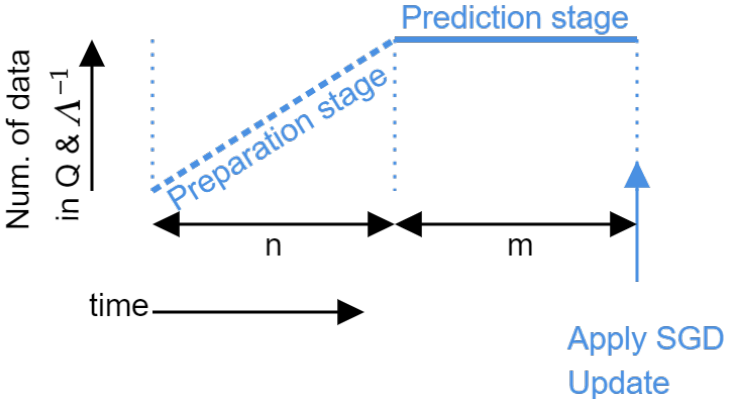
Figure 1. This figure shows one cycle of our algorithm. It has two stages: The first n time steps (preparation stage) computes Λ − 1 τ and Q τ with the updated prior parameters. The next m time steps (prediction stage) produces the predictive posterior and accumulates the prior updates. At the end of the second stage, the accumulated the prior updates are applied and change the prior parameters.